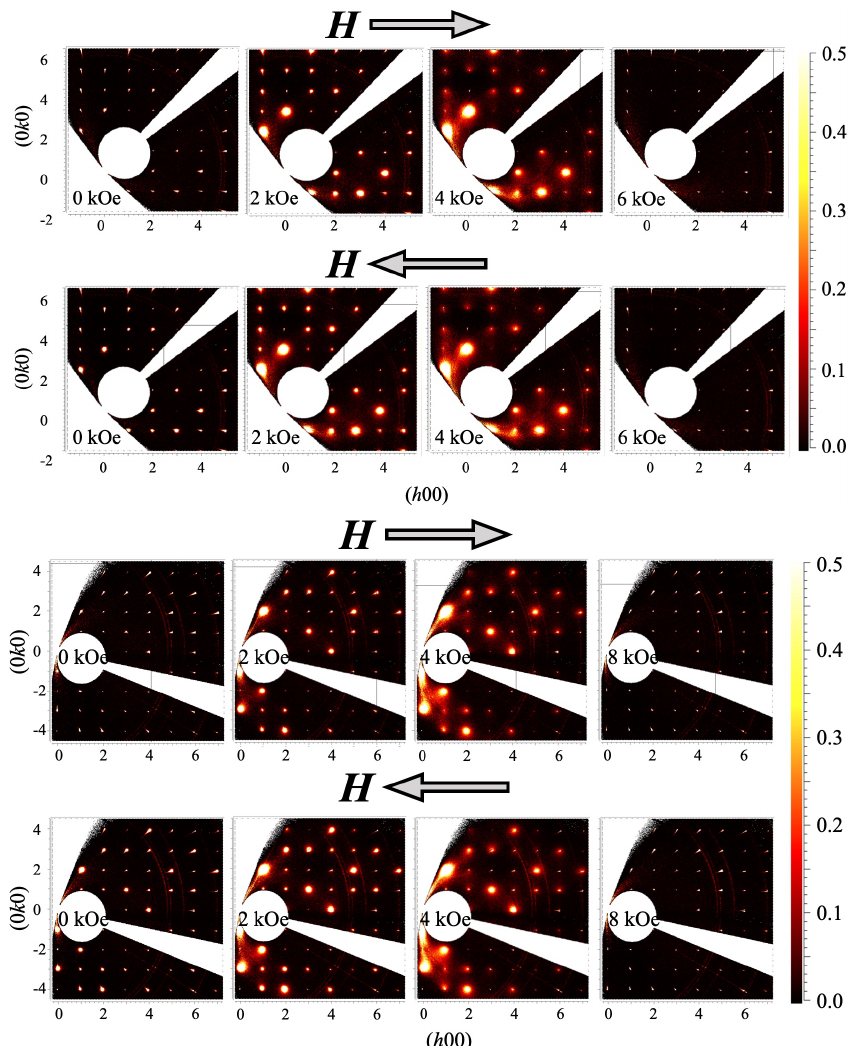
Figure A5: Comparison of the neutron diffraction intensity maps (background sub- tracted) in the ( hk 0 ) plane measured in a field applied parallel to the c axis. The temperature is 180 mK for the top panel and 60 mK for the bottom panel. For the bottom row in each panel, the field is decreasing from the maximum value of 30 kOe down to